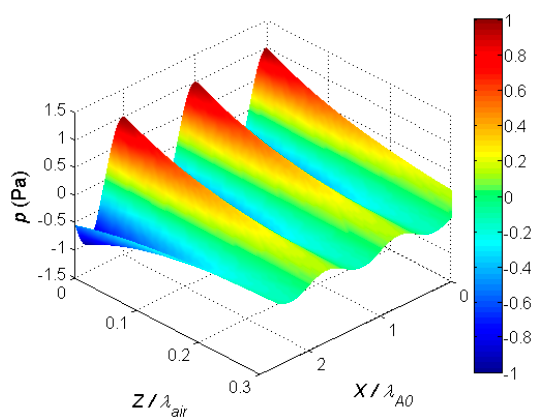
Figure 14. 3D spatial structure of evanescent wave field in air above PVC film.